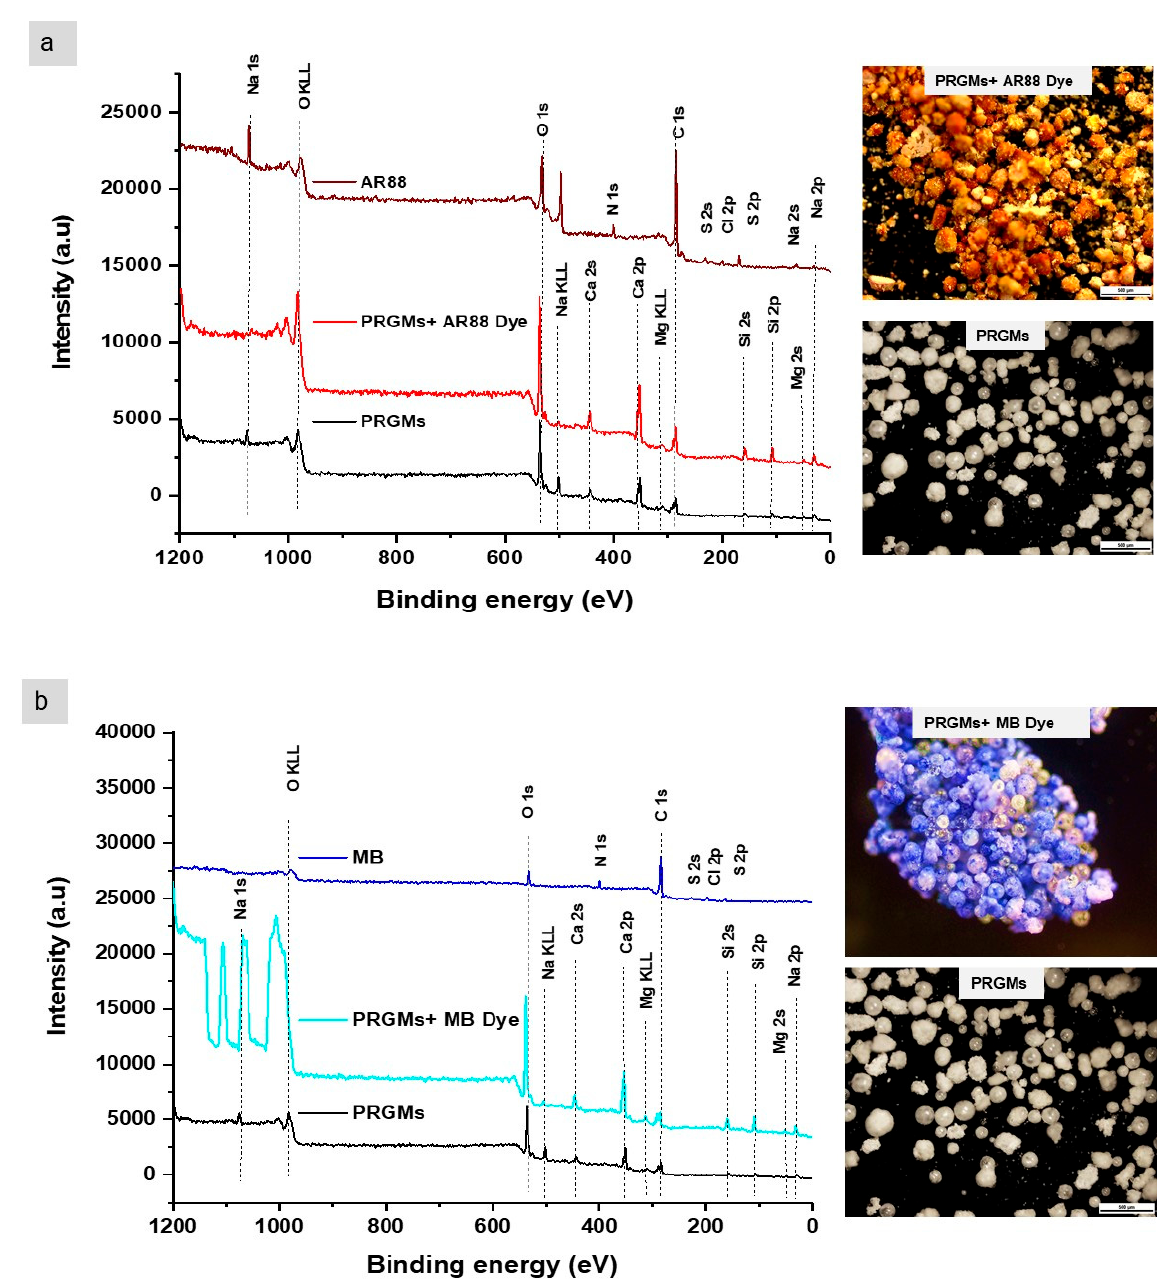
Figure 8. An XPS survey scan and optical microscopy images for PRGMs before and after ( a ) AR88 and ( b ) MB dye